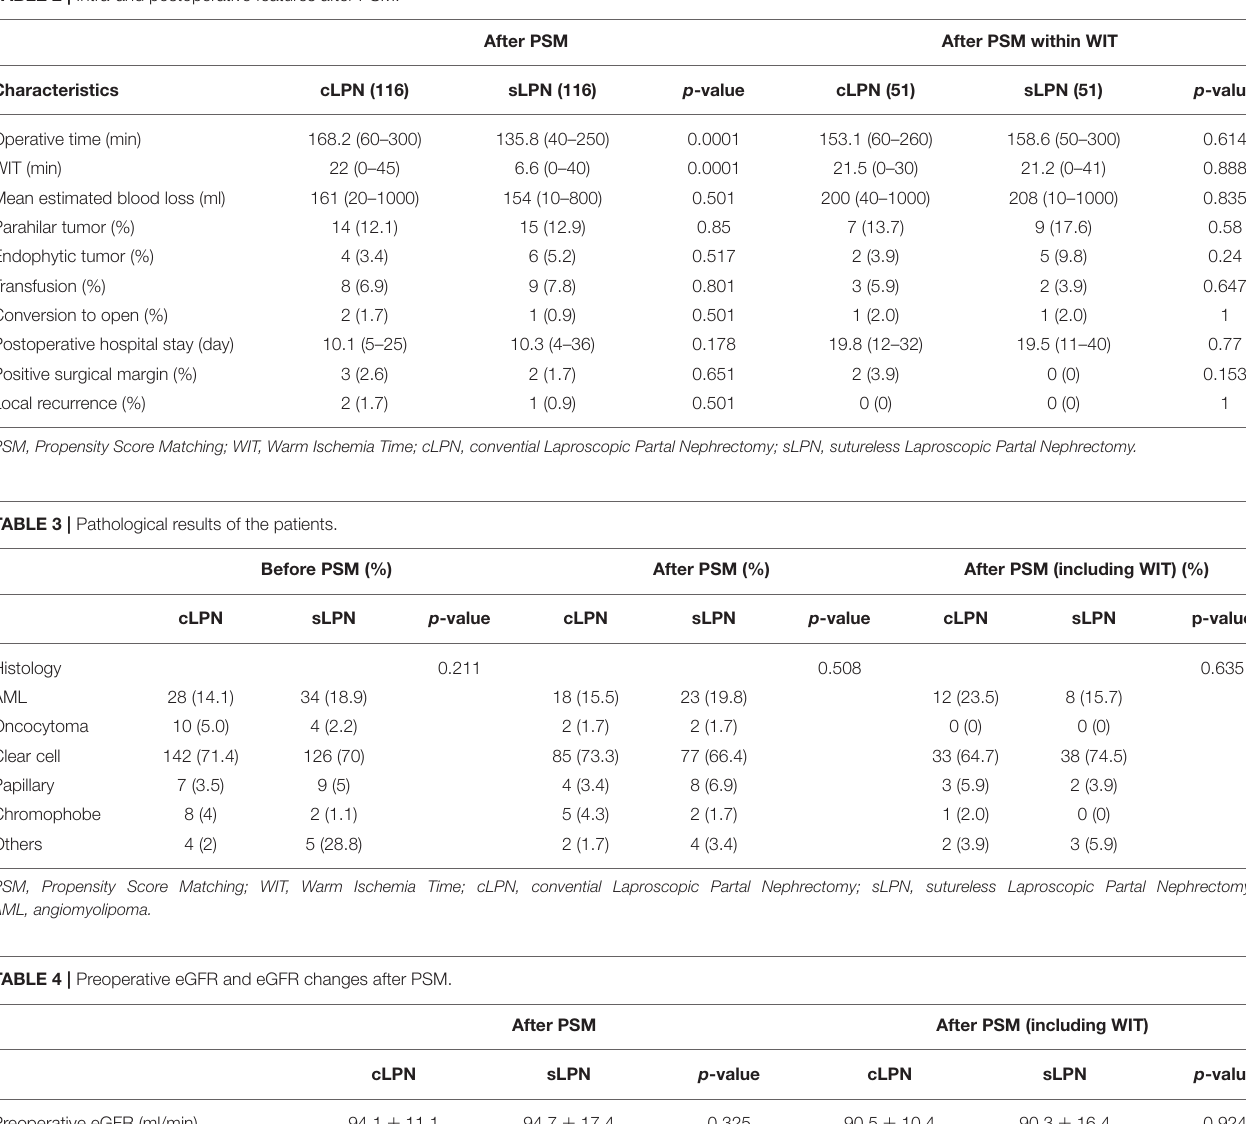
TABLE 2 | Intra-and postoperative features after PSM.